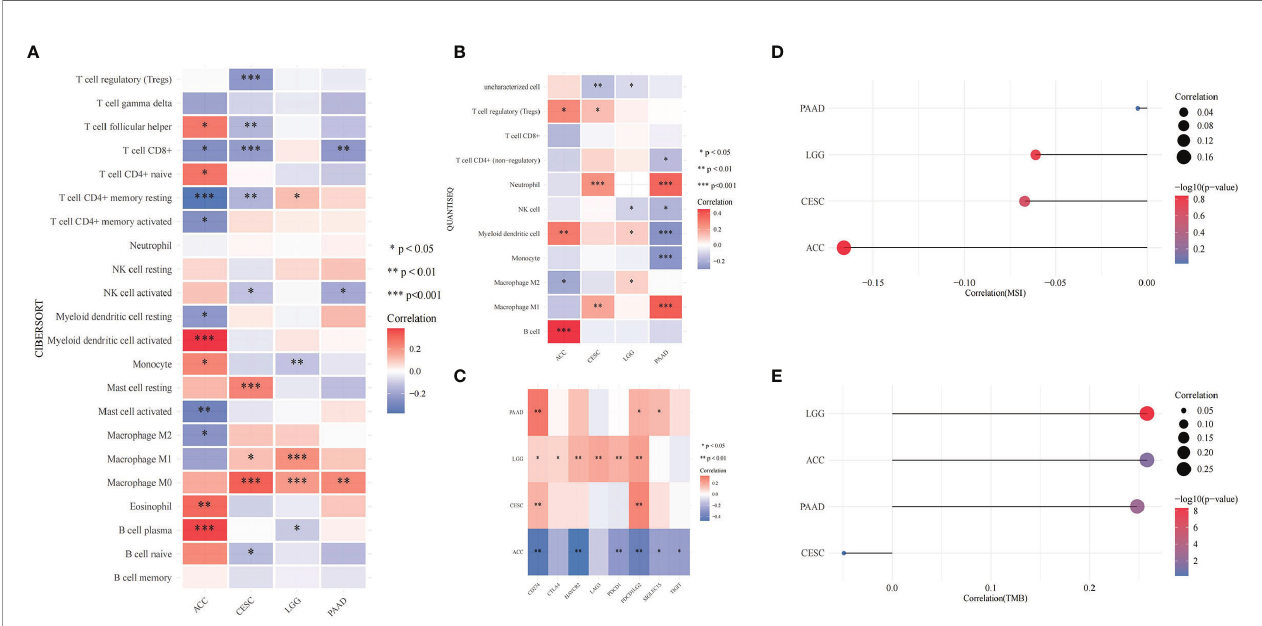
FIGURE 6 | Correlation of T. hemsleyanum -targeted protein CDK6 with immunity and mutation of four tumors. (A) Analysis of tumor immune cell in fi ltration by CIBERSORT. (B) Analysis of tumor immune cell in fi ltration by quanTIseq. (C) Correlation analysis of immune checkpoints. (D) Correlation analysis of microsatellite instability. (E) Correlation analysis of TMB. *p < 0.05, **p < 0.01, ***p < 0.001.